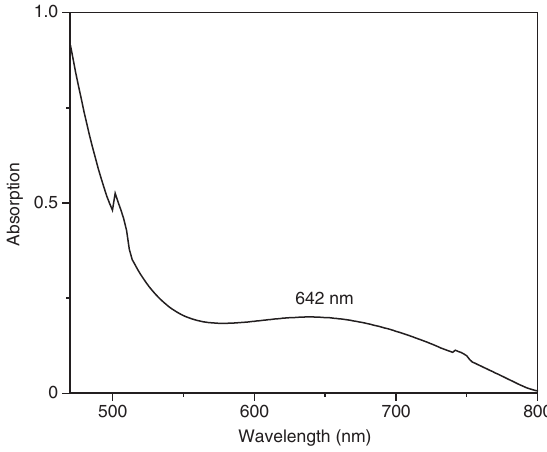
nanoparticles capped with 3